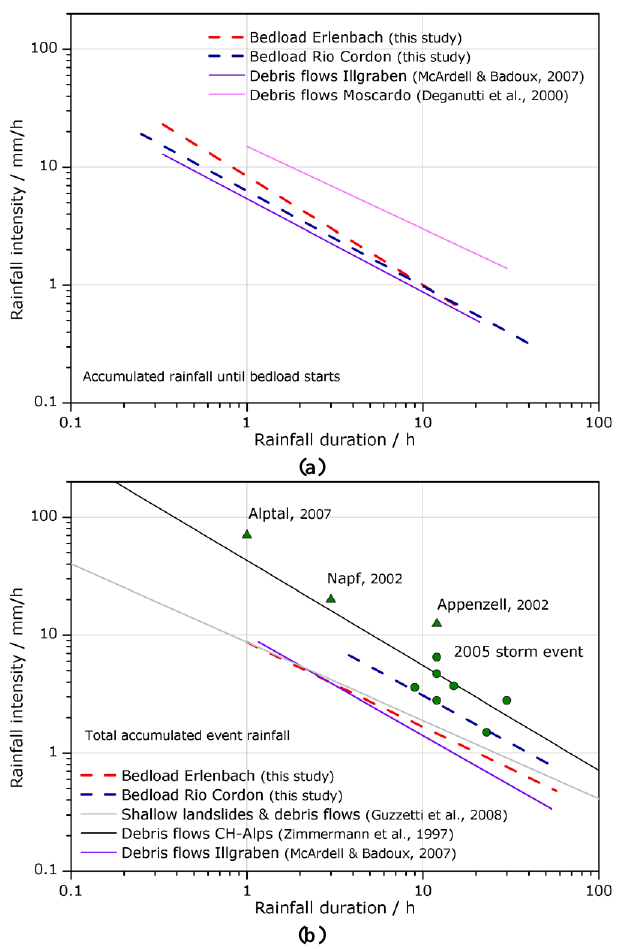
Fig. 10. Comparison of rainfall intensity–duration relationships for different natural hazard processes: (a) I BLS – D BLS relationships for the triggering of debris flows in the Moscardo torrent (Deganutti et al., 2000) and Illgraben torrent (McArdell and Badoux, 2007), as well as for the onset of bedload transport (this study); (b) I T – D T relationships for the occurrence of debris flows, shallow land- slides and bedload transport at different spatial scales. Triangles show rainfall characteristics of three convective summer storms that each triggered several hillslope debris flows and shallow landslides within a well-defined perimeter in Switzerland. Dots indicate rain- fall characteristics during the large 2005 storm event that lead to similar processes in different Swiss regions (Rickli et al.,